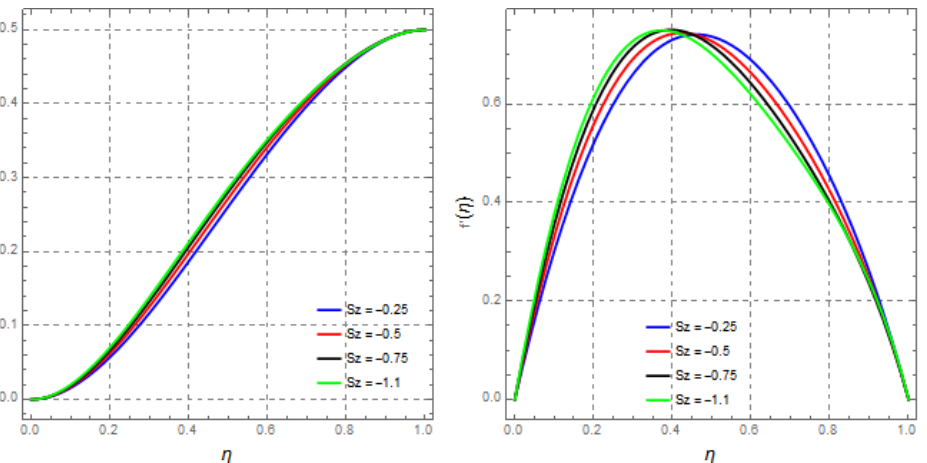
Figure 5. Impact of squeeze reynolds number S z on the velocity component f and f (cid:48) , keeping M x = − 3.25, M y = 10, R m = − 0.75, and S =